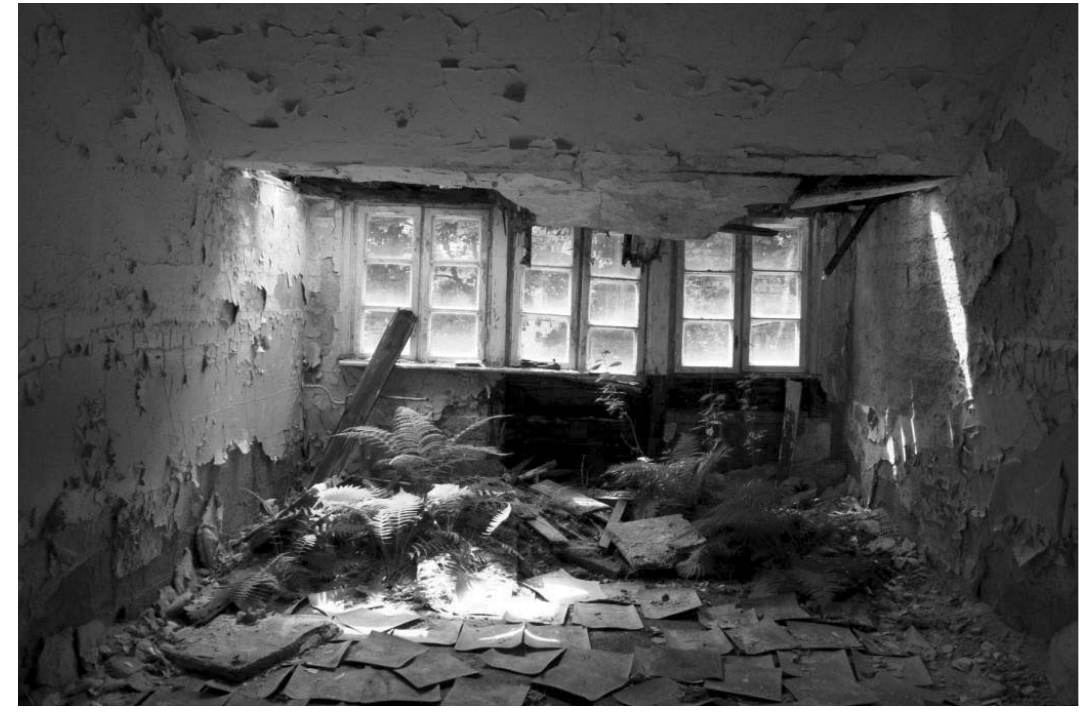
Abandoned soviet hospital in Legnica. Plants take over the place (own